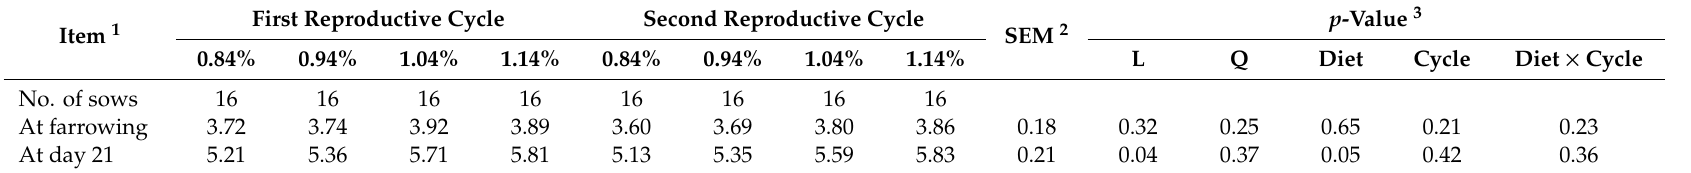
Table 5. E ff ects of di ff erent levels of lysine in lactation diets on plasma urea nitrogen (PUN) levels of